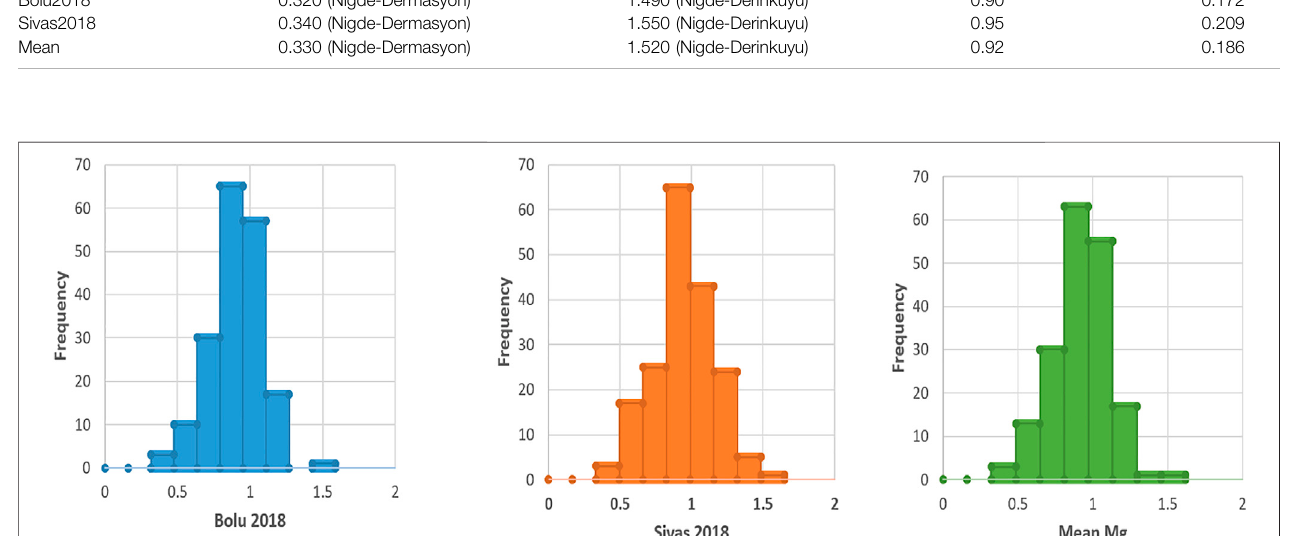
FIGURE 1 | Frequency distribution of Mg contents in Turkish common bean seeds.